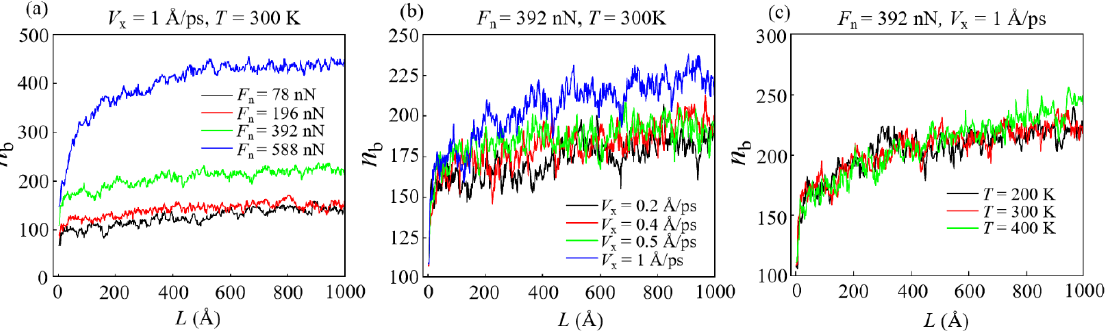
Figure 2. Number of bonds n b between the DLC film and the slider with different conditions: ( a ) V x = 1 Å/ps, T = 300 K; ( b ) F n = 392 nN, T = 300 K; ( c ) F n = 392 nN, V x = 1 Å/ps.